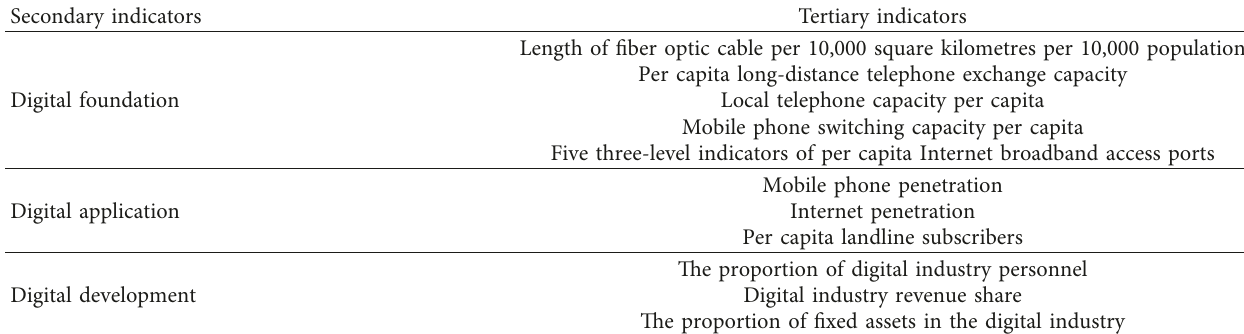
Table 1: Digitalization level indicator measurements.